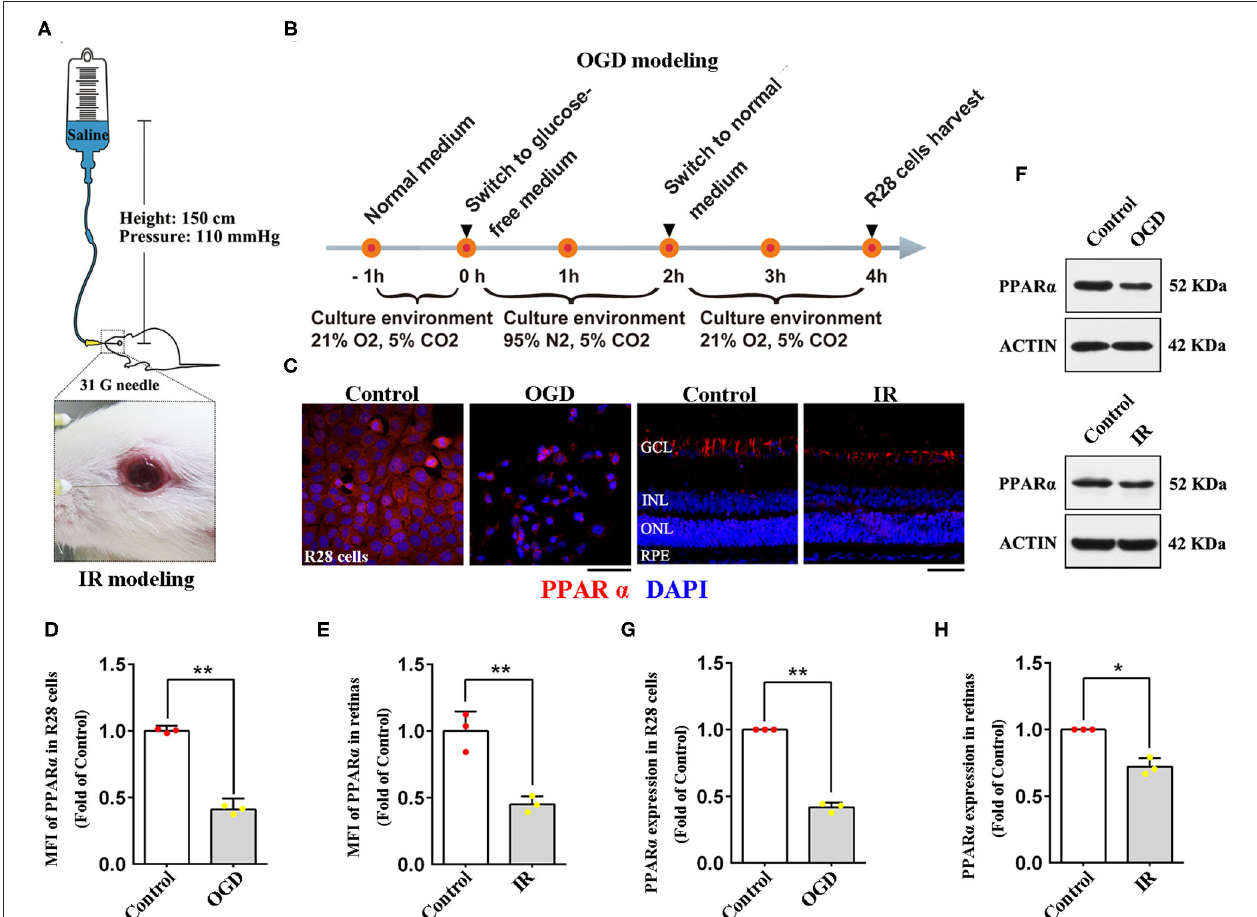
FIGURE 1 | Expression of PPAR α in IR-treated retinas (24h post-modeling) and OGD-treated R28 cells (2h post-modeling). (A) The diagrammatic picture of IR modeling. (B) The diagrammatic picture of OGD modeling. (C) Representative photomicrographs of immunostained PPAR α (red) and nuclei (blue; counterstained by DAPI) in R28 cells and retinas. (D,E) Graph showing the mean fluorescence intensity (MFI) of PPAR α in R28 cells and retinas. (F) The expression of PPAR α and actin detected by western blotting in R28 cells and retinas. (G,H) Average expression of PPAR α semi-quantified by densitometry and normalized to actin expression in